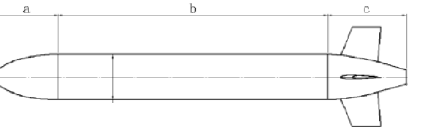
Figure 4. Myring shape outline . a is the forward flow line, b is the middle, c is the